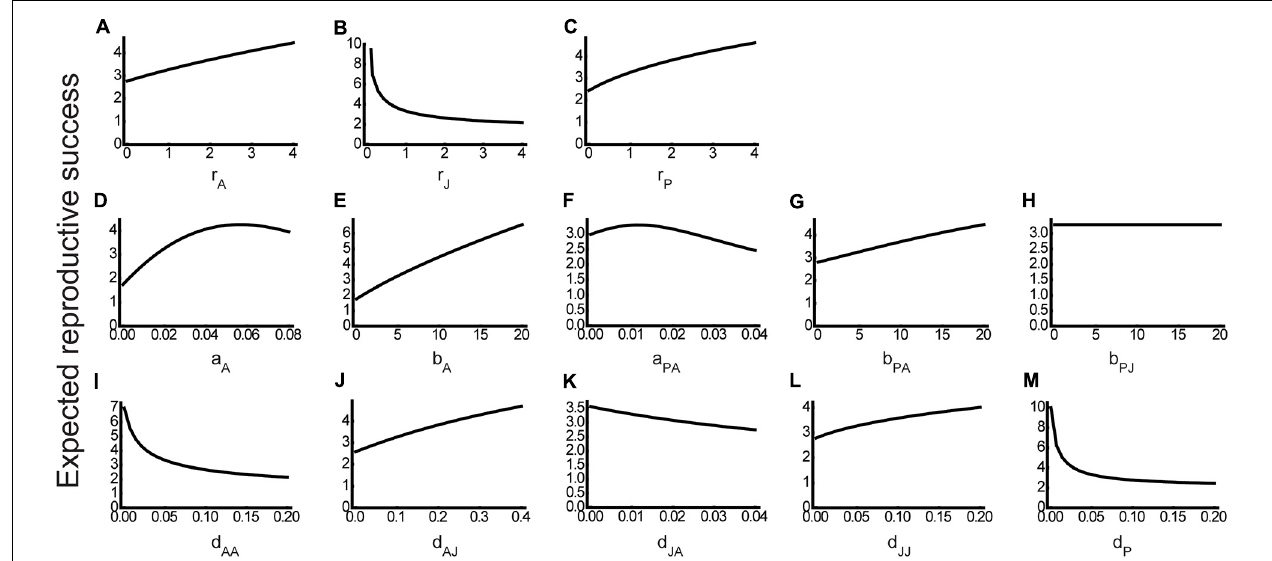
FIGURE 4 | Parameter effects on the expected reproductive success in the absence of juvenile-specific parasitism (a PJ = 0). In each panel, the expected reproductive success at the steady state is calculated along a different parameter: (A) r A , (B) r J , (C) r P , (D) a A , (E) b A , (F) a PA , (G) b PA , (H) b PJ , (I) d AA , (J) d AJ , (K) d JA , (L) d JJ , and (M) d P . Note that in panel (H) , the expected reproductive success is constant against the conversion efficiency of the juvenile-specific parasitism b PJ because this parameter is meaningless in the absence of juvenile-specific parasitism. Other parameter values are the same as in Figure 3 .